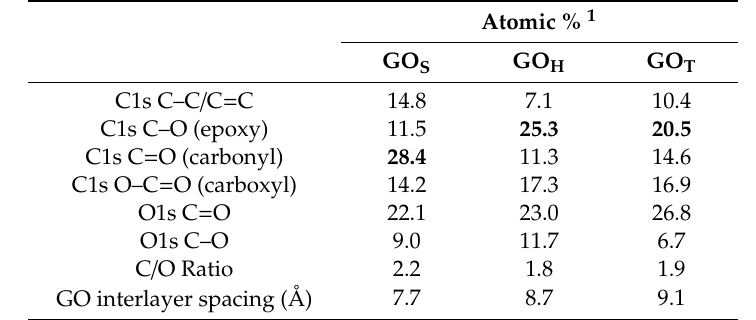
Table 1. X-ray photoelectron spectroscopy (XPS) atomic composition and X-ray di ff raction (XRD) interlayer spacing for graphene oxide (GO) variations; GO S , GO H and GO T